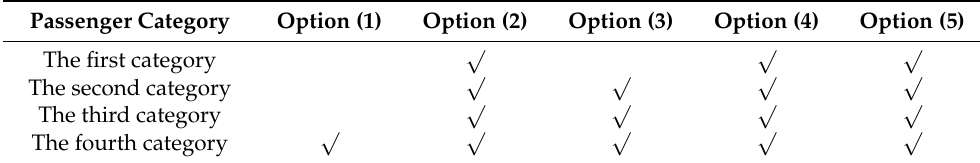
Table 3. The options for affected passengers of different